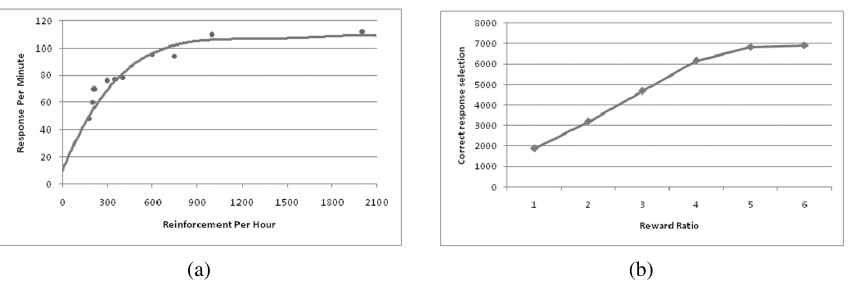
Figure 6. Experimental results showing an increasing trend of response rate for increasing the reinforcement rate. (a) Behavioral results. (b) Neurocomputational model